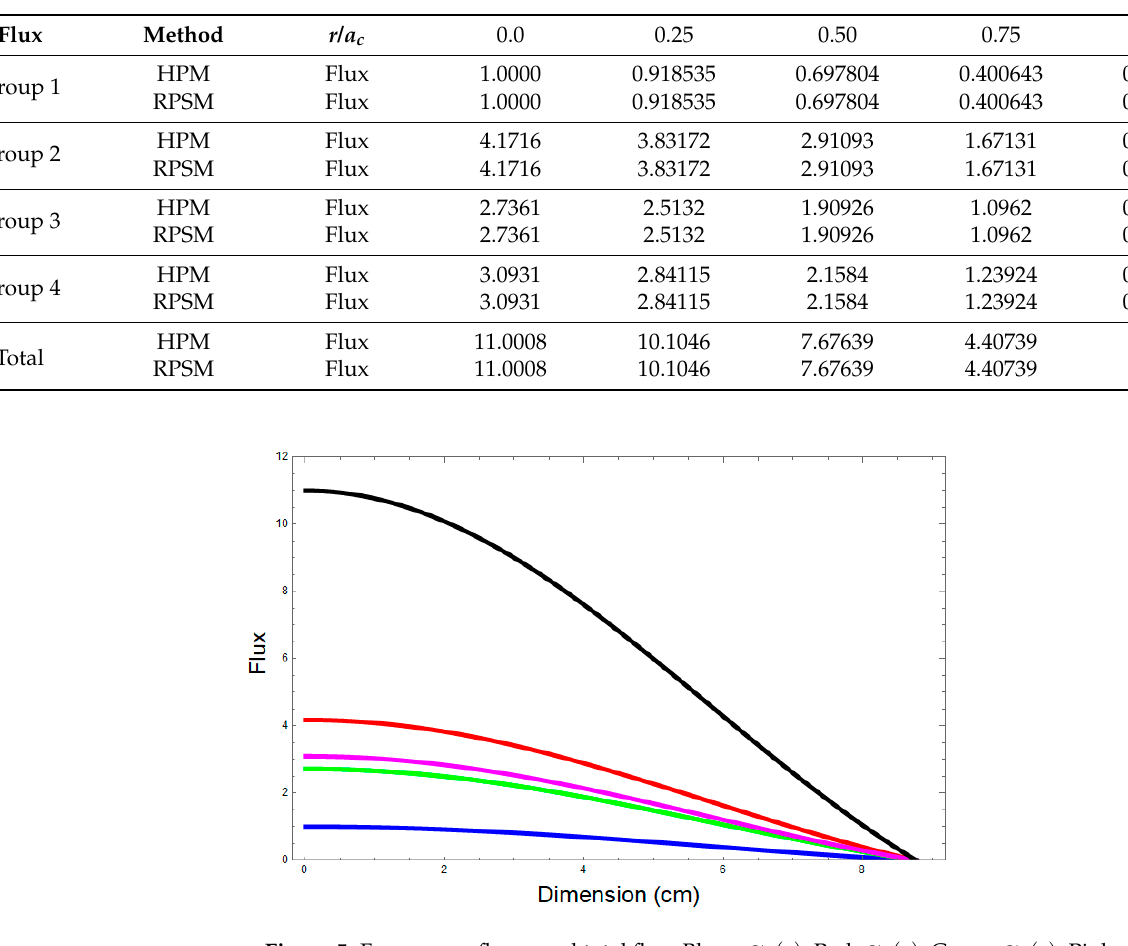
Table 18. Four-group fluxes and total flux reactor.